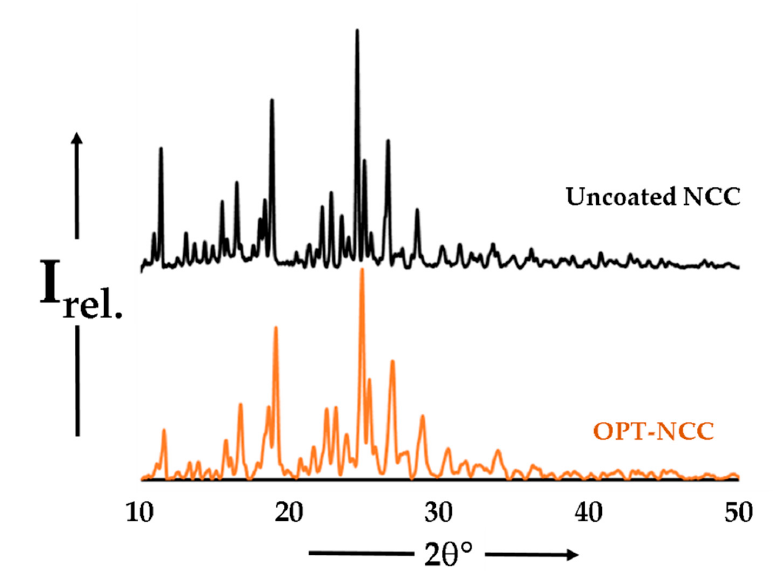
Figure 7. PXRD diffractograms for the uncoated (black) and OPT-NCC (orange). Figure 7. PXRD di ff ractograms for the uncoated (black) and OPT-NCC (orange).